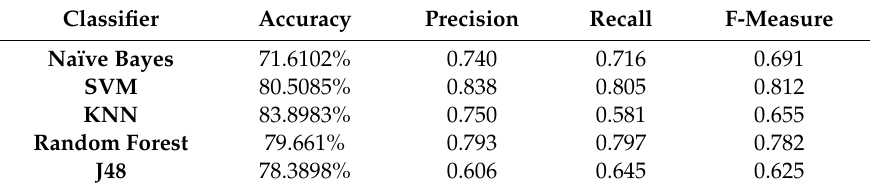
Table 3. Performance metrics for TX–RX of 20 cm features (632 features per case).